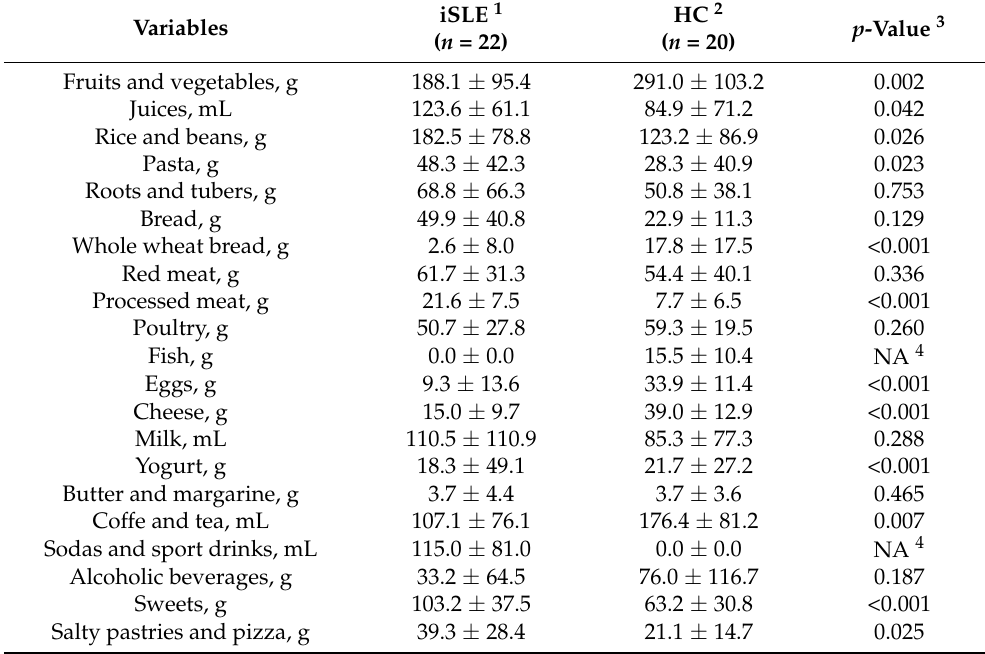
Table 3. Daily intake means of food groups of